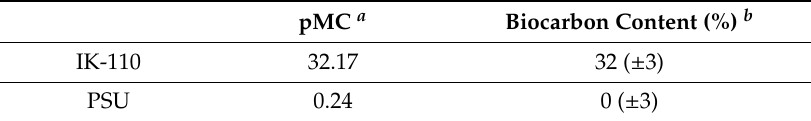
Table 2. 14 C-based biomass carbon content measured by